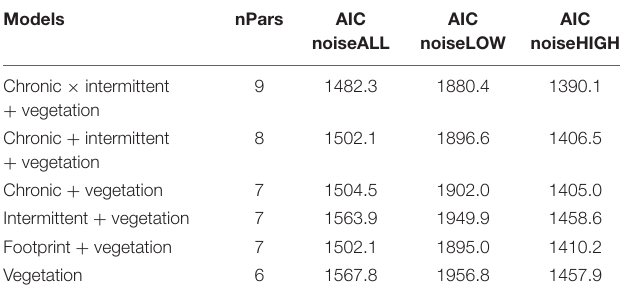
nPars, number of